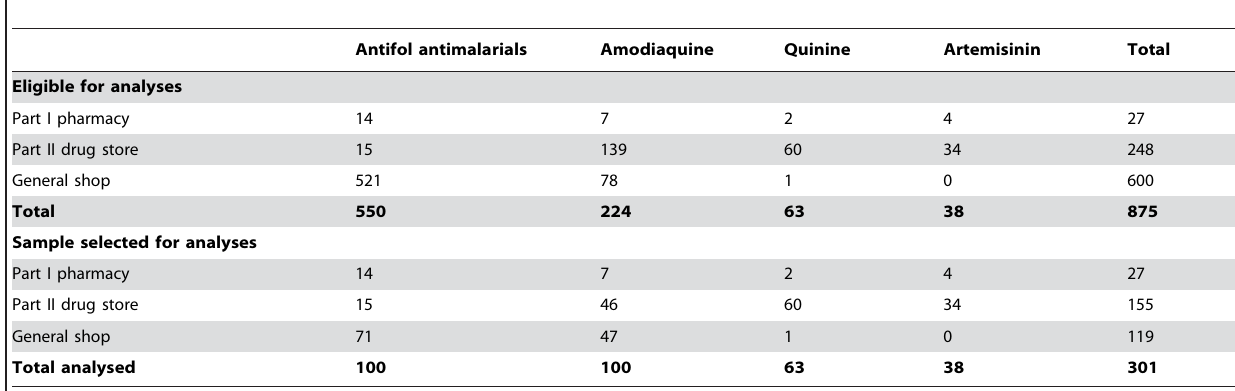
Table 2. Antimalarial drug samples eligible and selected for analyses, by content and source, 2005.